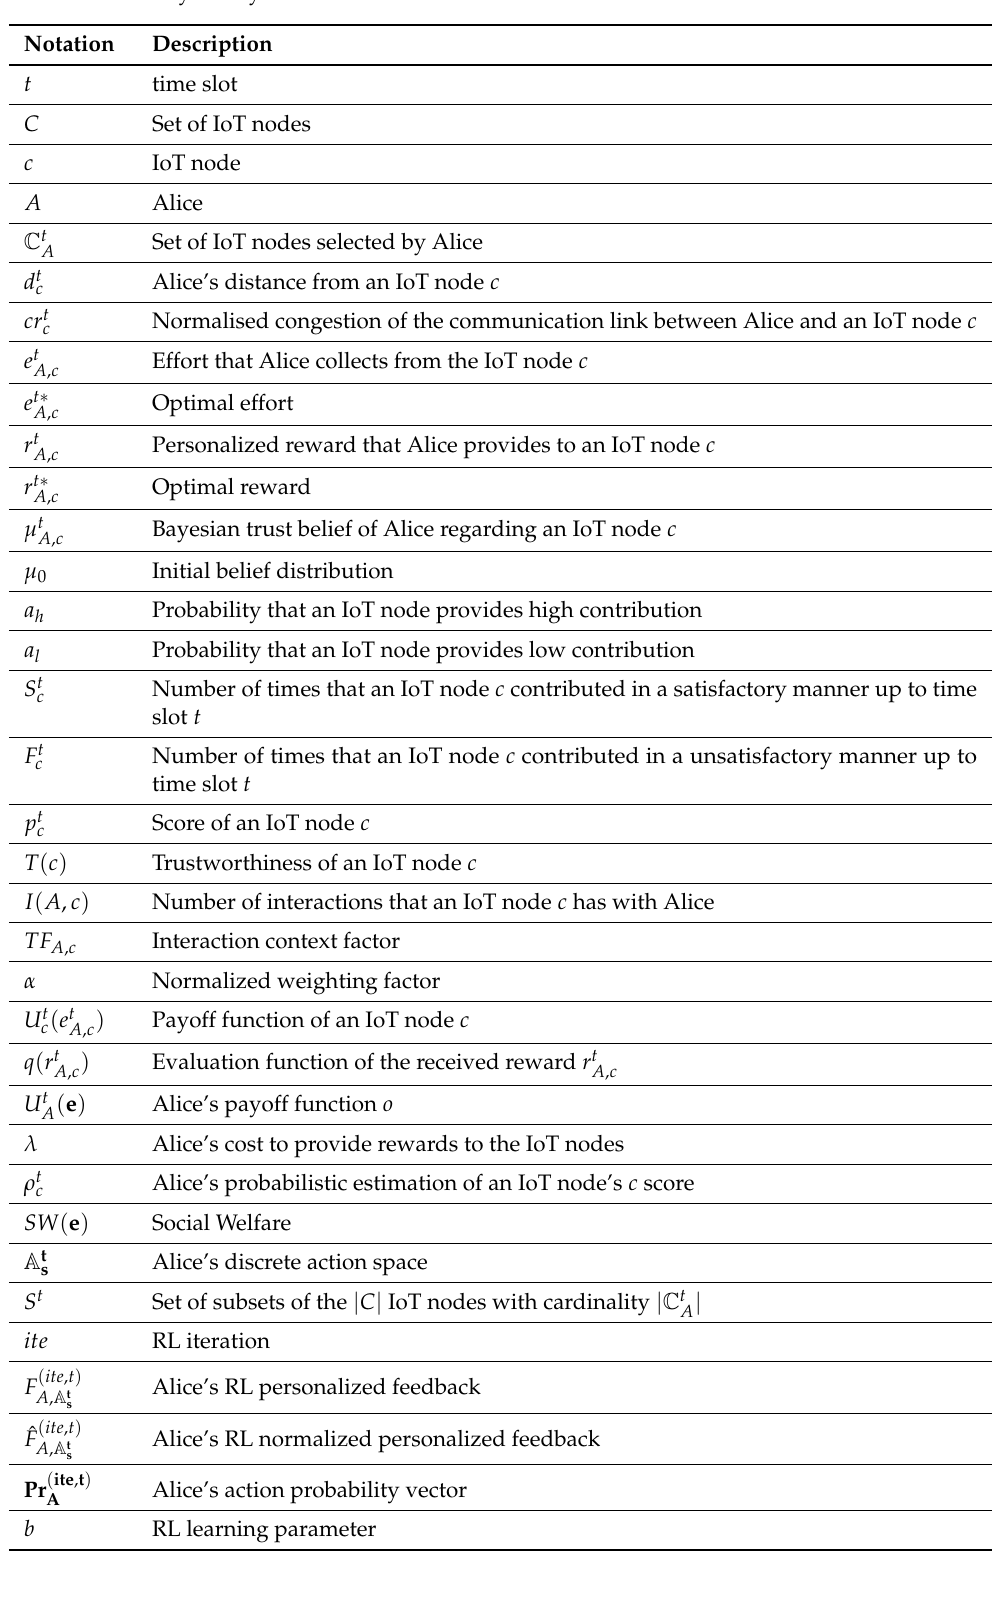
Table 1. Summary of Key